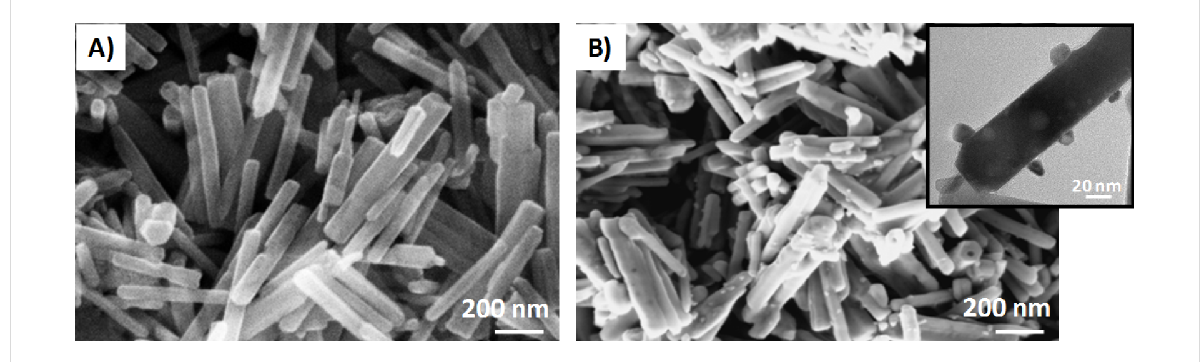
Figure 3: SEM images of A) pristine and B) Pd-modified ZnO nanostructures, after thermal annealing at 550 °C. The inset shows the TEM image of Pd@ZnO NRs.